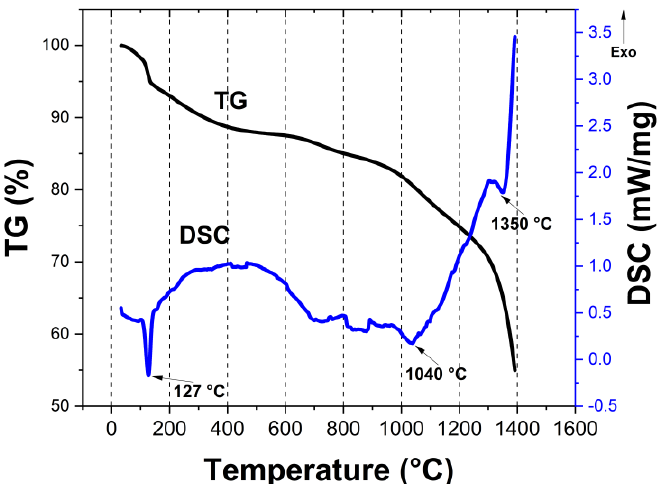
Figure 5. TG-DSC curves of the SCB-S1 hybrid gel under flowing argon.